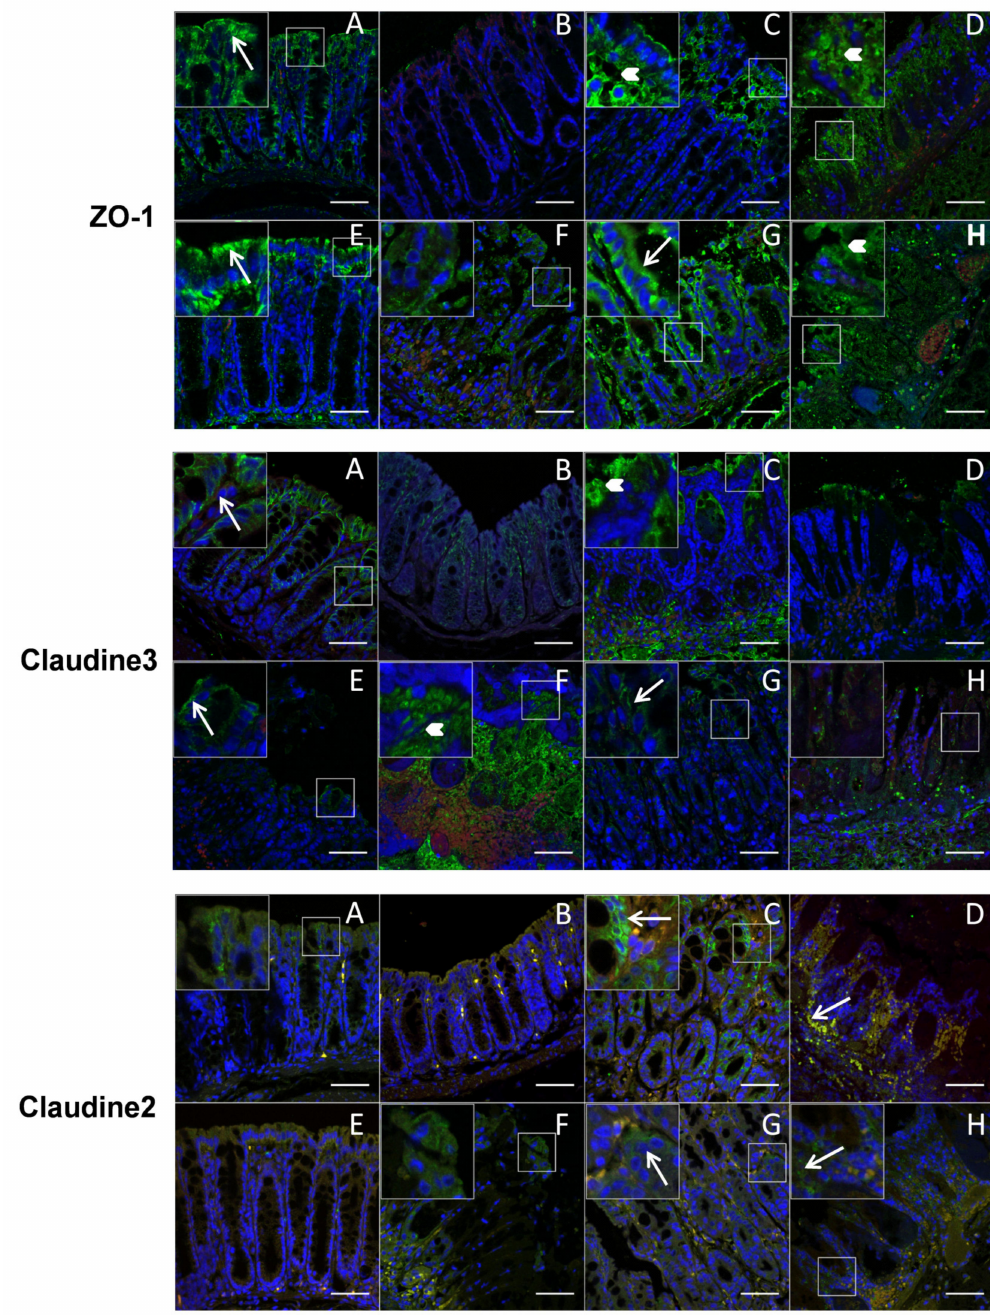
Figure 6. Ability of the strains to modulate tight junction proteins in the colon. Representative immunofluorescent images of ZO-1, Claudin-3 and Claudin-2 of colon sections of the di ff erent groups of mice ( A ): healthy mice; ( B ): ethanol, ( C ): TNBS; ( D ): TNBS + PF-BaE7; ( E ): TNBS + PF-BaE11; ( F ): TNBS + AS93; ( G ): TNBS + PF-BaE5 and ( H ): TNBS + AS23, observed by immunofluorescence and confocal microscopy after labeling with specific primary antibodies and AF488-conjugated secondary antibody (green), with nuclei counterstained with DAPI (blue) stain. A red canal was added to identify autofluorescence tissue elements (red / yellow) and reinforce the specific labeling. Boxed areas represent magnified images ( × 2.5) as insets from the corresponding white box. Long arrows indicate normal TJ (ZO-1 and Claudin-3) distribution at the apical and lateral levels and labeling for Claudin-2; short arrows indicate discontinuities or di ff use cytoplasmic distribution of TJ. Scale bars 50 µ